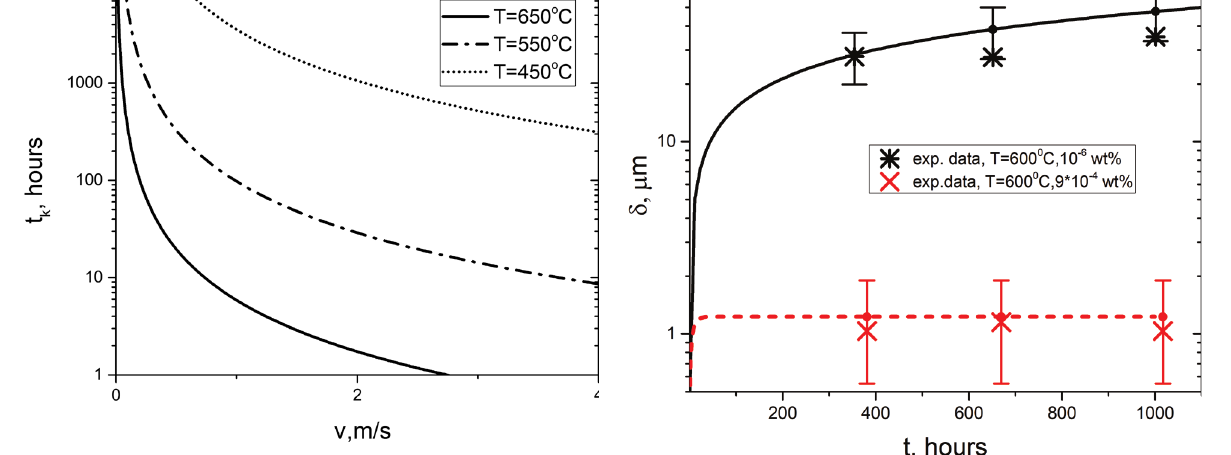
Figure 6. Dependence of the transition time to parabolic film growth on the coolant velocity at a basic oxygen concentration 10 -8 kg/kg.